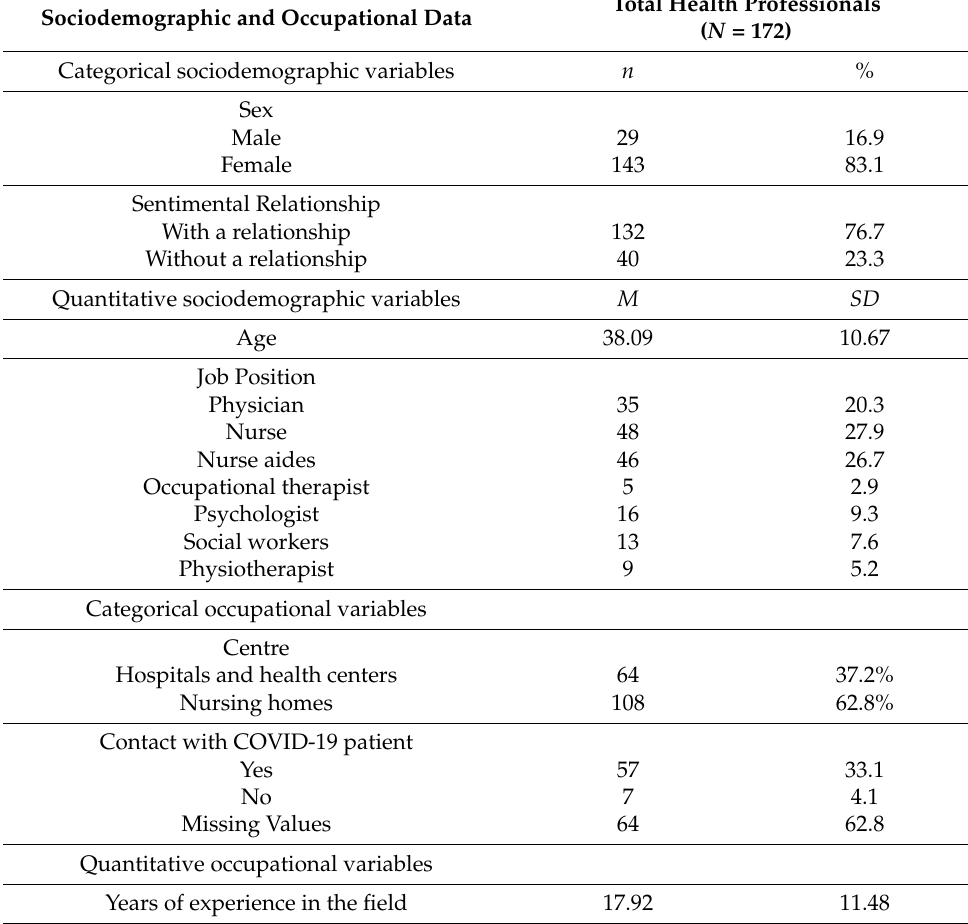
Total Health Professionals